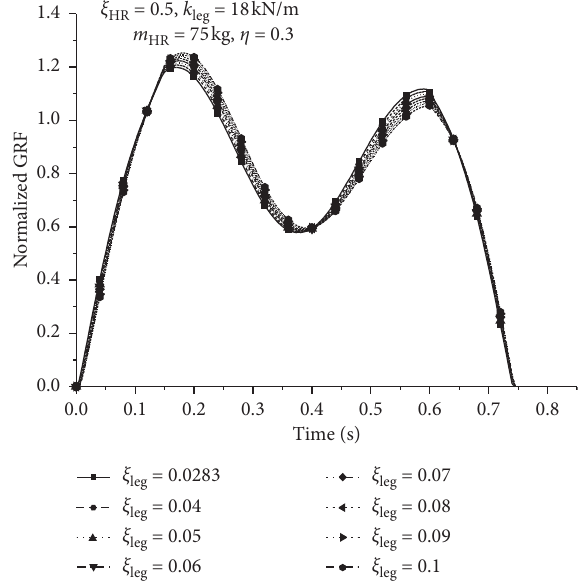
Figure 19: Normalized GRF under different leg damping